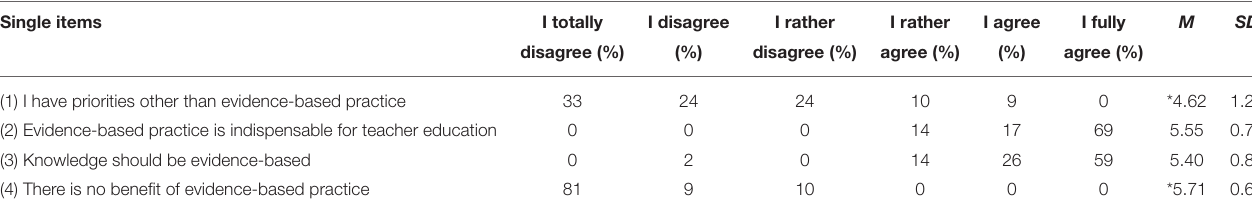
TABLE 2 | Descriptive statistics for attitudes: percentage of nominations, mean values (M), and standard deviation (SD) of the single items. Single items I